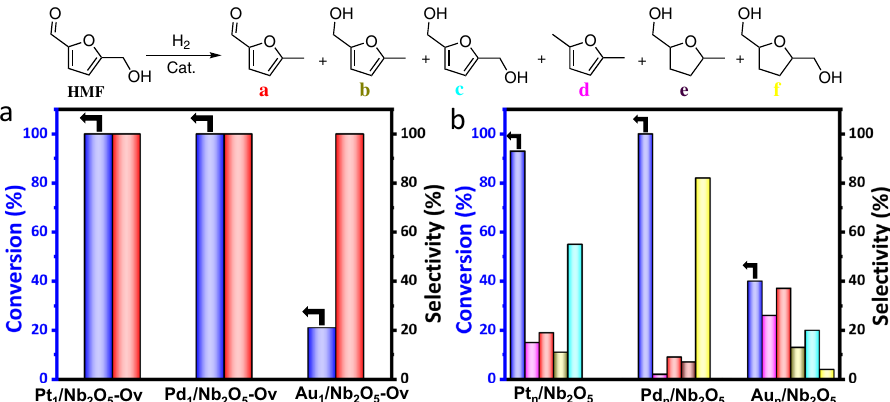
Fig. 7 Catalytic performance of M 1 /Nb 2 O 5 -Ov and M n /Nb 2 O 5 . Reaction results for the catalyst of a Pt 1 /Nb 2 O 5 -Ov, Pd 1 /Nb 2 O 5 -Ov, and Au 1 /Nb 2 O 5 -Ov, reaction time 4 h; b Pt n /Nb 2 O 5 , Pd n /Nb 2 O 5 , and Au n /Nb 2 O 5 , reaction time 1 h; reaction condition: substrate (0.3 mmol), catalyst (20 mg), THF (2.0 mL), H 2 (4.0 MPa), 160 °C. The products were detected by gas chromatography. The black arrows points to the conversion of 10 h. After being cooled to room temperature, the white precipitate was separated n-decane were purchased from J&K, which were all analytical grade. H 2 (>99.99%) by high-speed centrifugation, washed with ethanol for three times and distilled and Ar (>99.99%) were supplied by Beijing Analytical Instrument Company. water for three times, and then dried in an oven at 70°C for 6 h. The grinded Ultrapure water (resistivity ≥ 18M Ω cm) was used in the experiments. All chemicals powder was calcined in a tube furnace (Anhui Kemi Machinery Technology Co., were used without further puri fi cation. Ltd.; Model TFV-1200-50-I-220) at 500°C for 4h (reducing gas contains 10 vol.% hydrogen and 90 vol.% argon) to obtain defective Nb 2 O 5 supports with surface oxygen vacancies. Synthesis of Nb 2 O 5 with oxygen-rich vacancy . Nb 2 O 5 with oxygen-rich vacancy defects (Nb 2 O 5 -Ov) were prepared by the sol-gel method using CTAB as the surfactant. In all, 0.538g of Niobium(V) oxalate hydrate was dissolved in 20mL of ultrapure water, and a clear solution was obtained after stirring 2h at room temperature. In all, 20mL of CTAB surfactant solution (0.2 M) was added drop wise into the above prepared solution, followed stirring for 2h at room tempera- ture. Then they were transferred into a dried Te fl on autoclave with a capacity of 100 mL at ambient temperature, followed by hydrothermal treatment at 180°C for 4 h and followed by aging for 4h, the solution was centrifuged and washed with